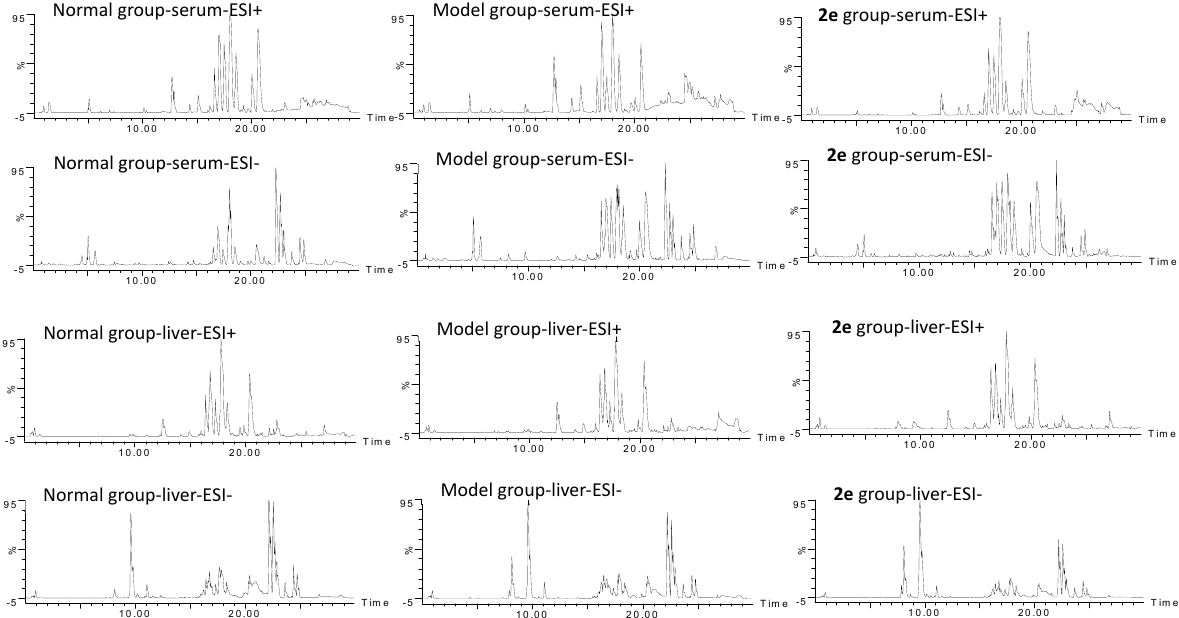
Figure 5. The representative base peak intensity (BPI) chromatograms in ESI+ and ESI– modes.